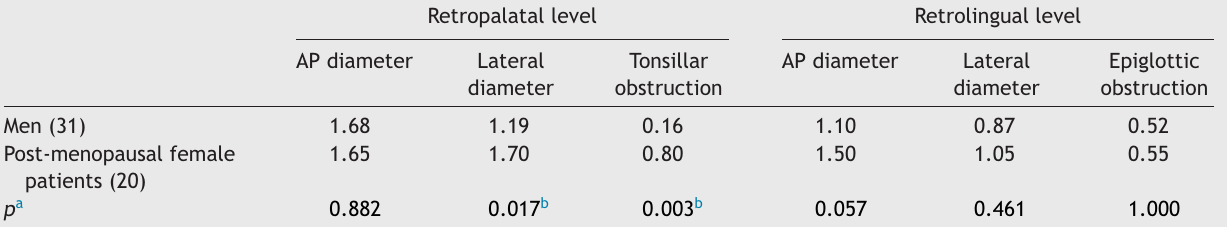
Comparison of DISE score between post-menopausal female patients (BMI ≥ 25) and men (age ≥ 50; BMI ≥ 25).